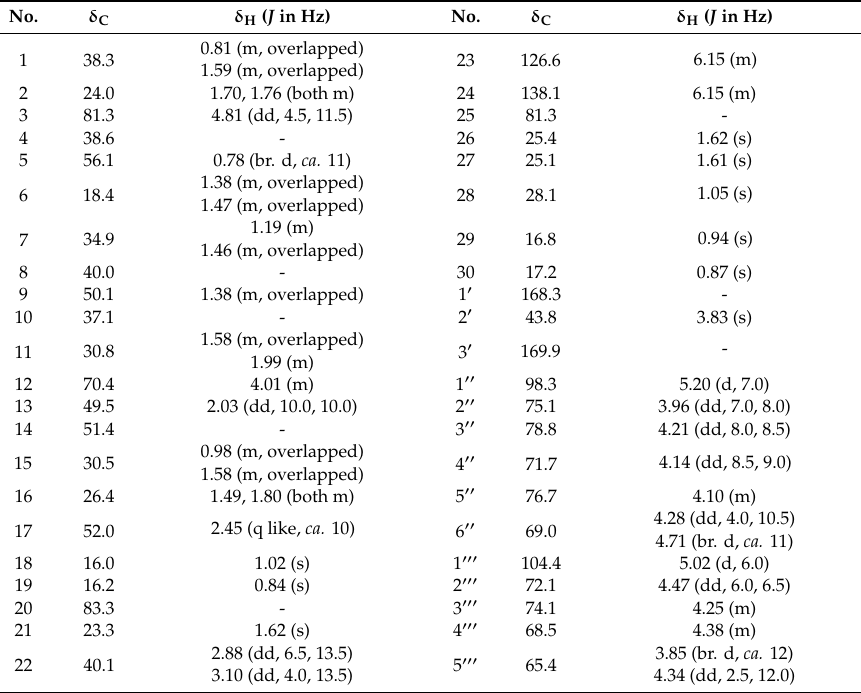
Table 4. The 1 H and 13 C-NMR data for 4 in C 5 D 5